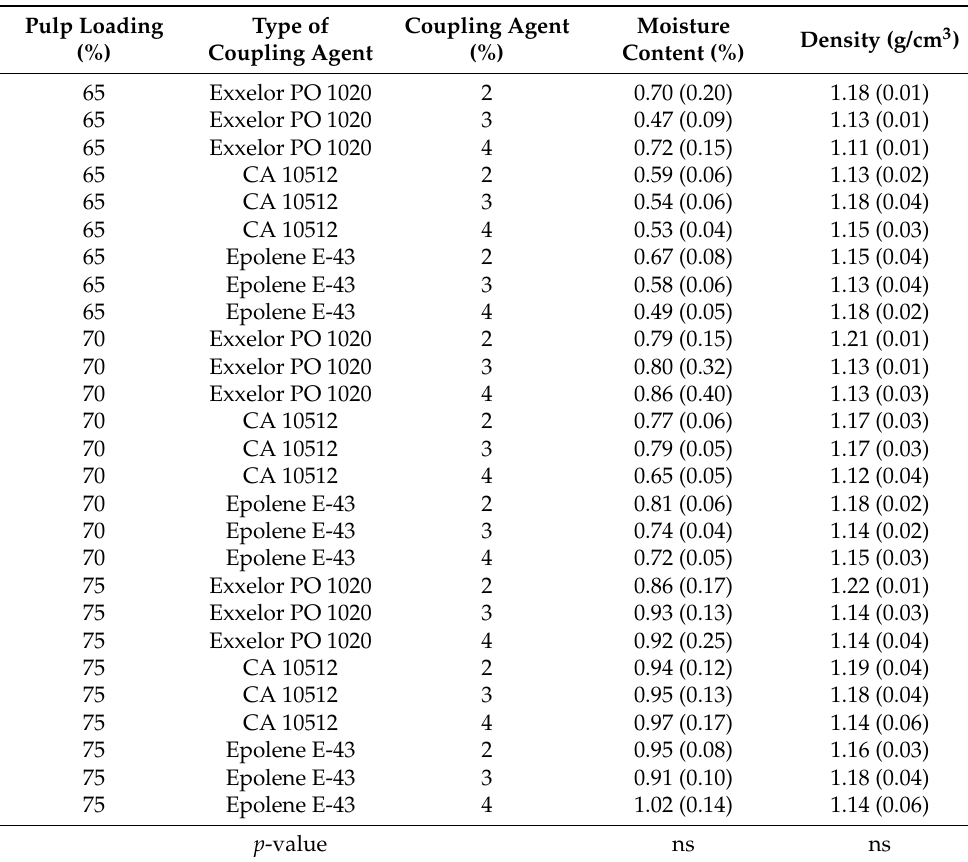
Table 5. Moisture content and density values of PP/OPTP composites with different material loading